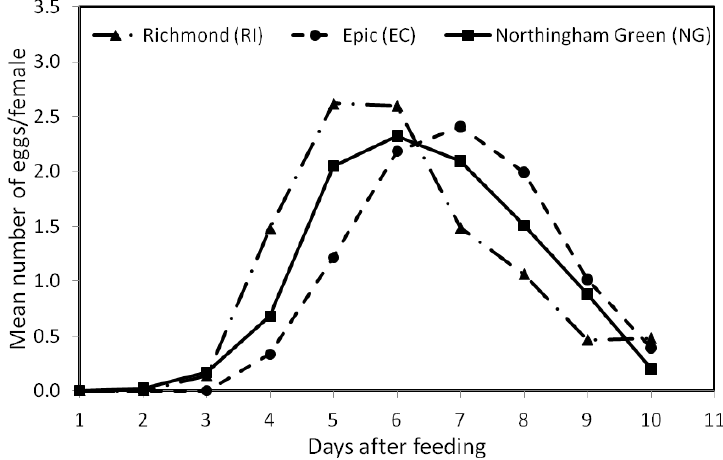
Figure 2. Mean number of eggs produced by females of three bed bug stains (Richmond-RI, Epic Center-EC, and Nottingham Green-NG) on specific days after feeding during 13 feeding/oviposition cycles. The three strains had significantly different ( p < 0.05) egg production patterns across days after